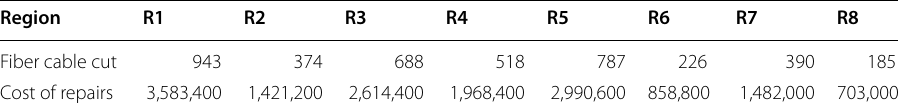
Table 3 Distribution of regional cable cuts and the total cost of repairing cuts in each region Region